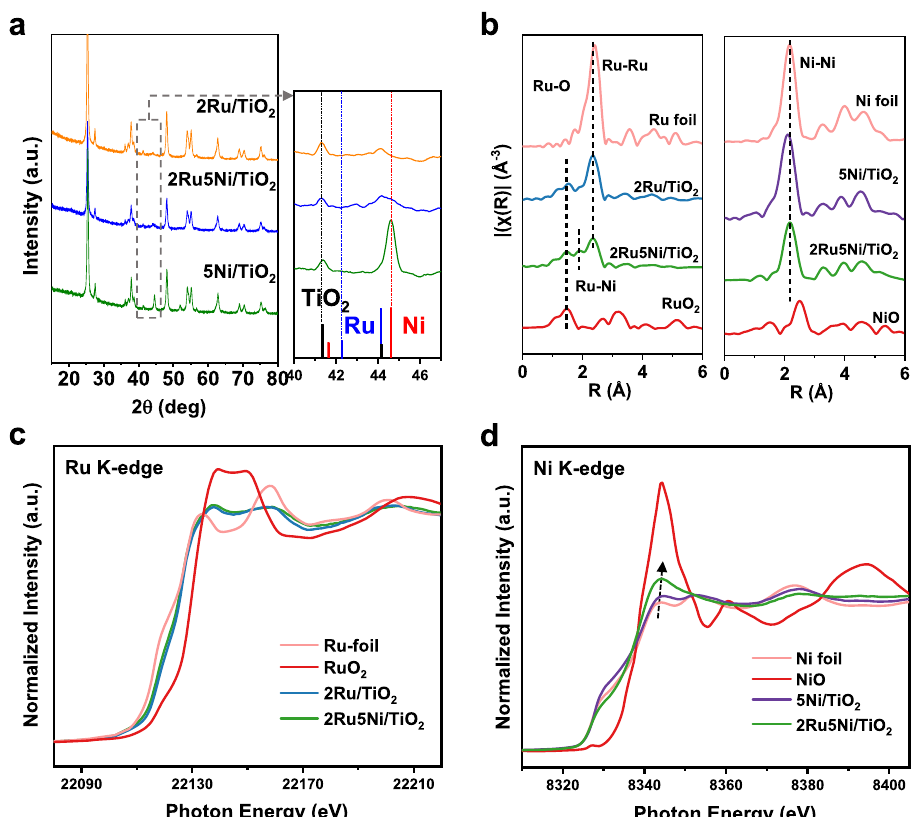
Fig. 3 | Structural characterization of 2Ru/TiO 2 , 2Ru5Ni/TiO 2 , and 5Ni/TiO 2 catalysts.a XRDpatternsofthereduced2Ru/TiO 2 ,2Ru5Ni/TiO 2 ,and5Ni/TiO 2 with the part of 2 θ =40 – 47° were enlarged at right. b Fourier-transform EXAFS spectra